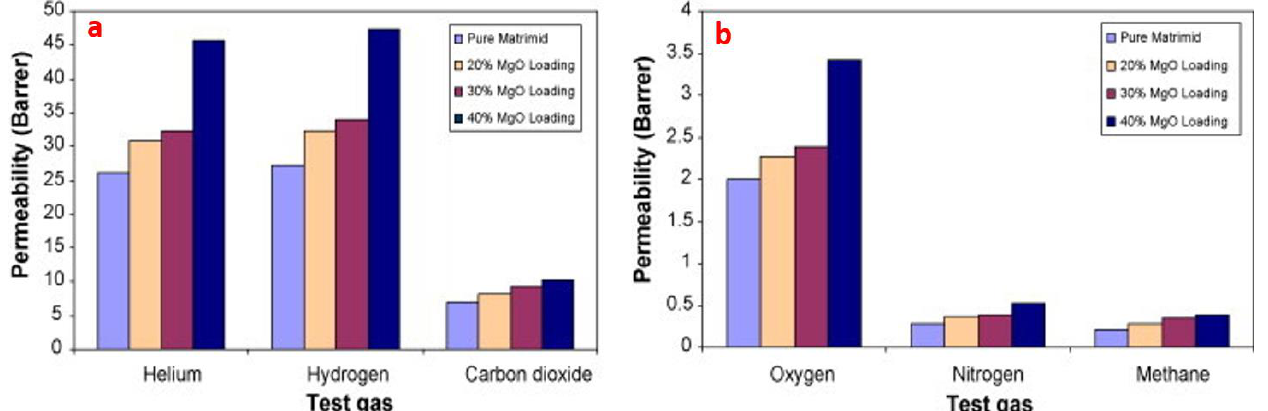
Figure 8. Comparison between gas permeability of pure Matrimid and its nanocomposite membranes having different concentrations of MgO NPs; ( a ) shows the comparison of helium, hydrogen, and carbon dioxide; ( b ) shows the comparison of oxygen, nitrogen, and methane. Reprinted with permission from [87]. Copyright (2007) Elsevier B.V.